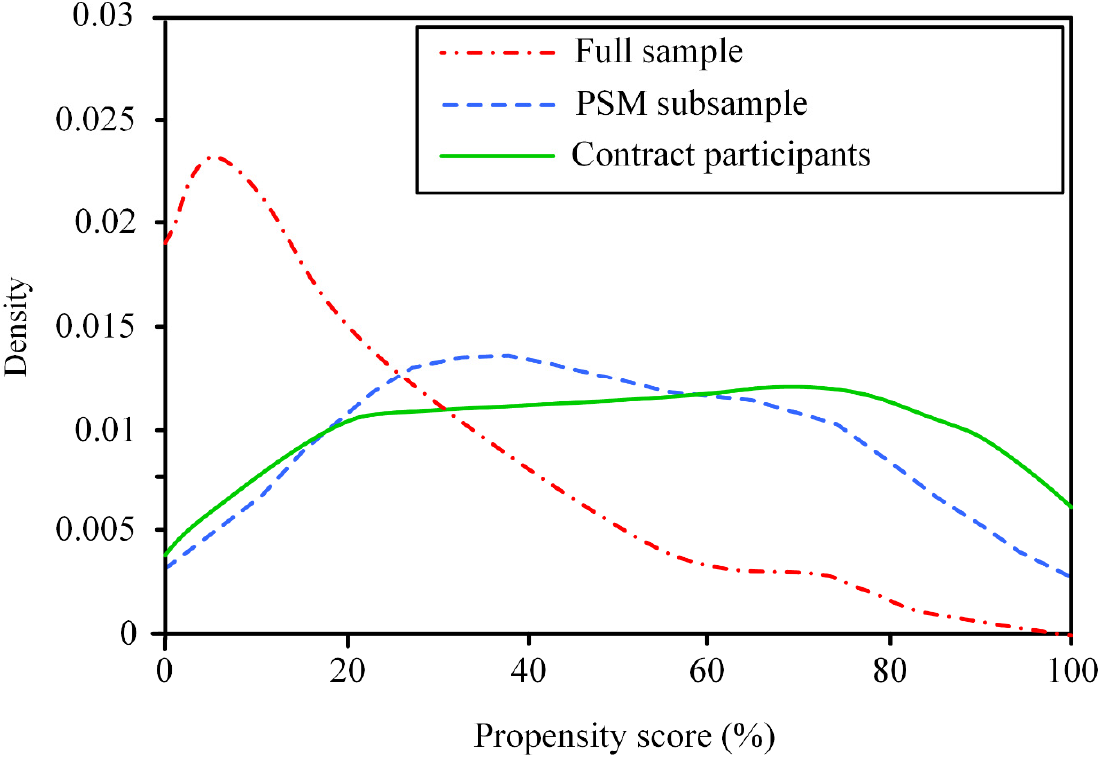
Figure 2. Kernel densities for propensity scores.